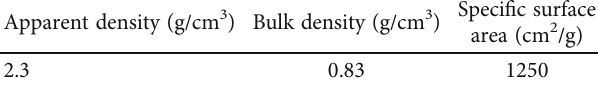
Table 2: Physical properties of fl y